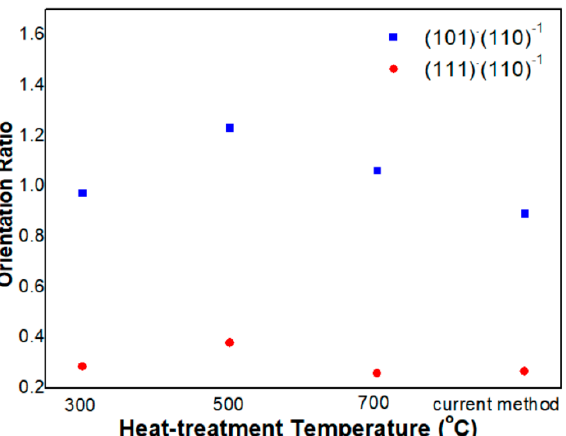
Figure 6. Crystal orientation of the SnO 2 -Pd NPs synthesized under different conditions.